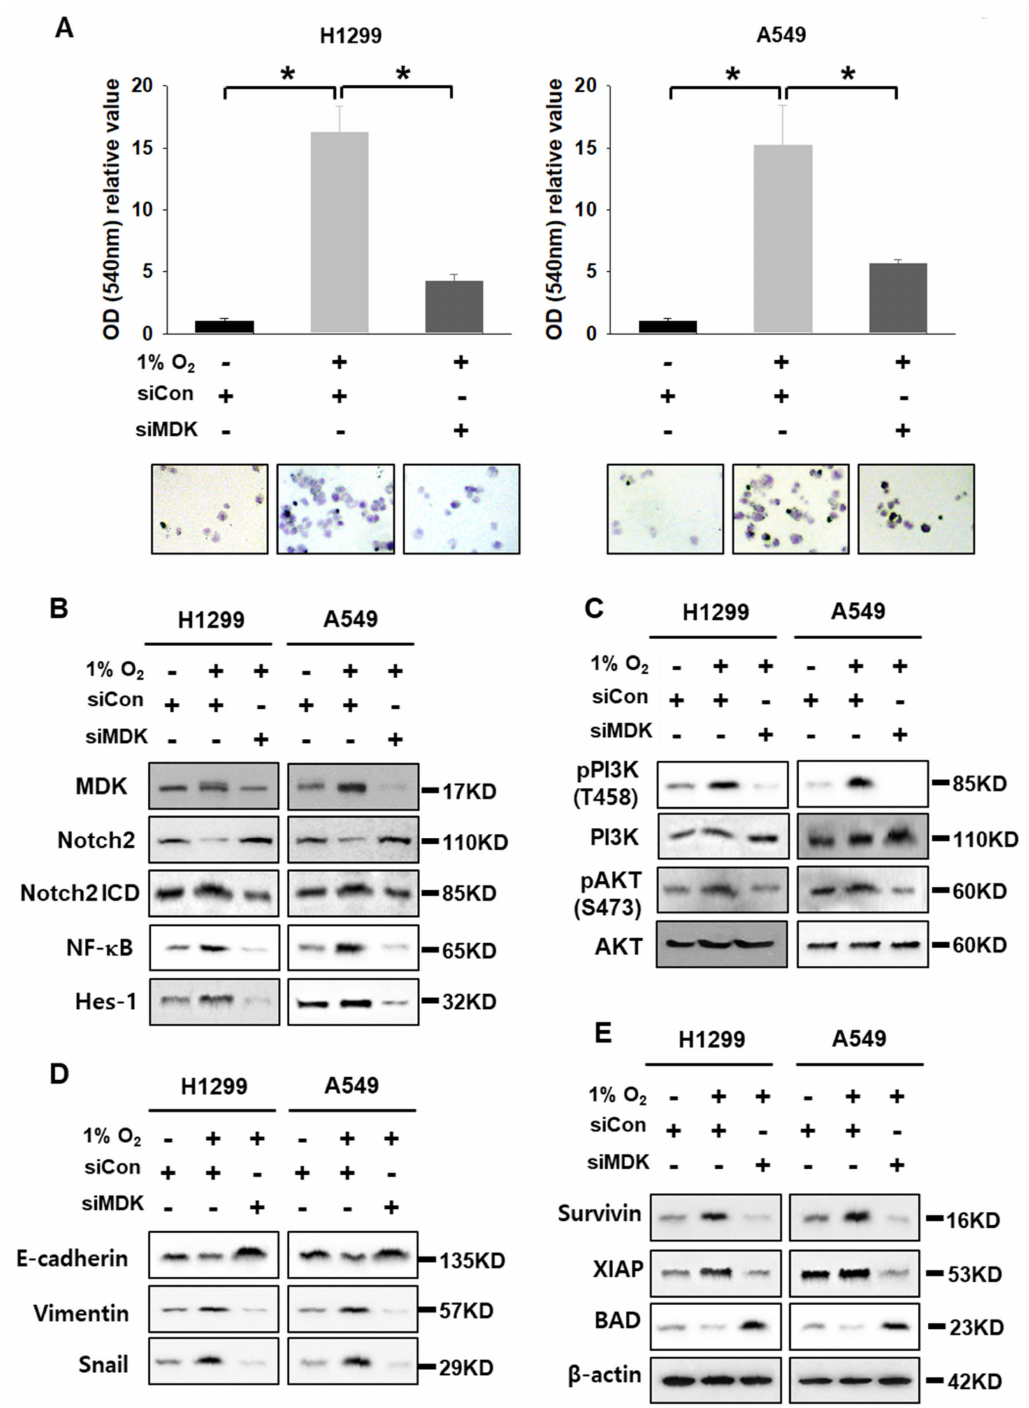
Figure 4. MDK knock down inhibits MDK-related signaling. siCon and siMDK were transfected with H1299 and A549 cells, and then cell migration and signaling were measured by immunoblotting assays after exposure to normoxic or hypoxic conditions. ( A ) H1299 and A549 cells were plated in serum-free medium onto the upper chamber, and 10% FBS medium was contained in the bottom chamber to act as a chemoattractant; the cells were incubated at 37 ◦ C in a CO 2 incubator for 16 h. Student’s t test was performed and the values displayed as average ± SD; n = 6, * p < 0.05. ( B ) Identification of MDK-Notch2-Hes-1 signaling. ( C ) Checking the PI3K-AKT signaling. ( D ) Examining the EMT-related proteins. ( E ) Checking anti-apoptotic and pro-apoptotic